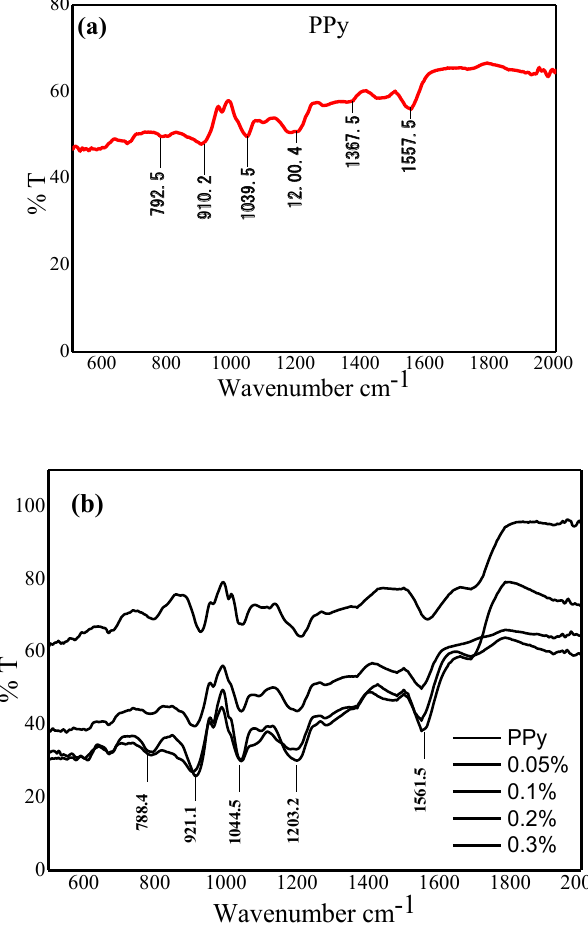
Fig. 4. FT-IR spectra of pure PPy (a) and NiO-PPy nanocomposites